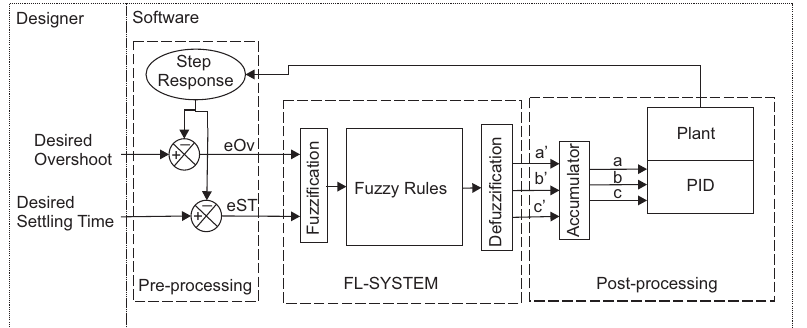
Figure 3. FL-based system for PID